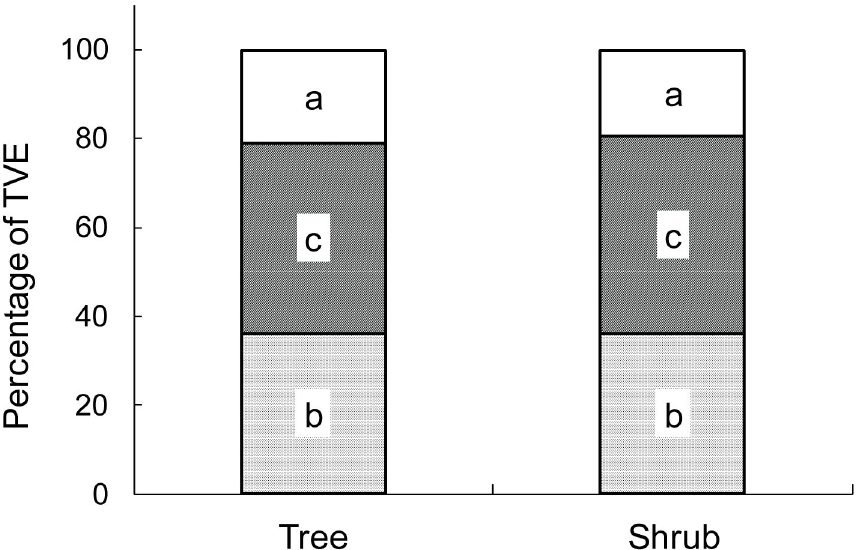
Figure 5. Variation decomposition shown as a percentage of total variation explained (TVE) for separate analyses of tree (Figure 3) and shrub (Figure 4) plots, that were uniquely related to variable groupings that included (a) soil organic carbon and total nitrogen, (b) % sand and % clay; or (c) an equal sharing by a and b. doi: